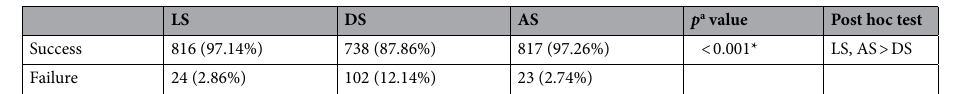
Table 3. Comparison of success rate among three methods. Success rates for automatic segmentation were 97.26 and 97.14% for the AS and LS, respectively, which were higher than the 87.86% success rate of the DS. Data are given as n (percentage). a p values were derived from Cochran’s Q test; * p < 0.05.